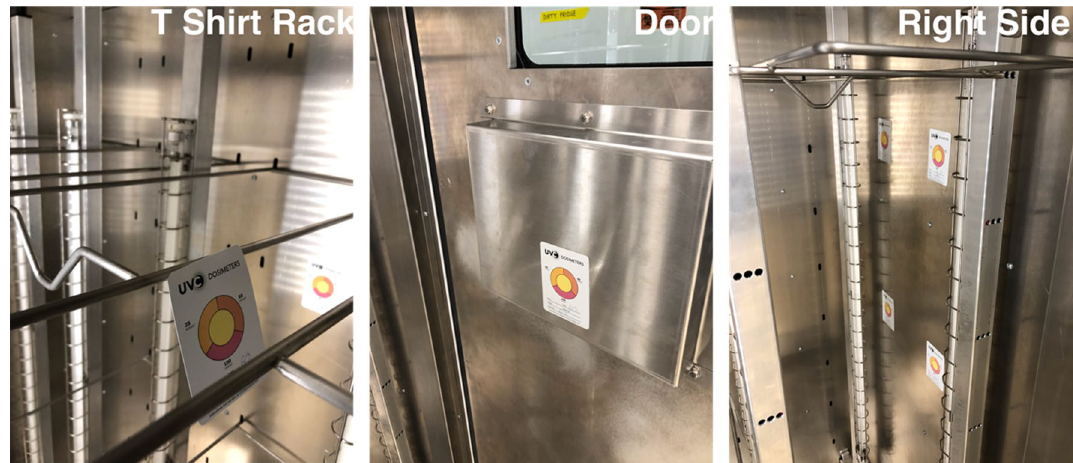
Figure 3. Internal layout of dosimetry coupons within the UV-C